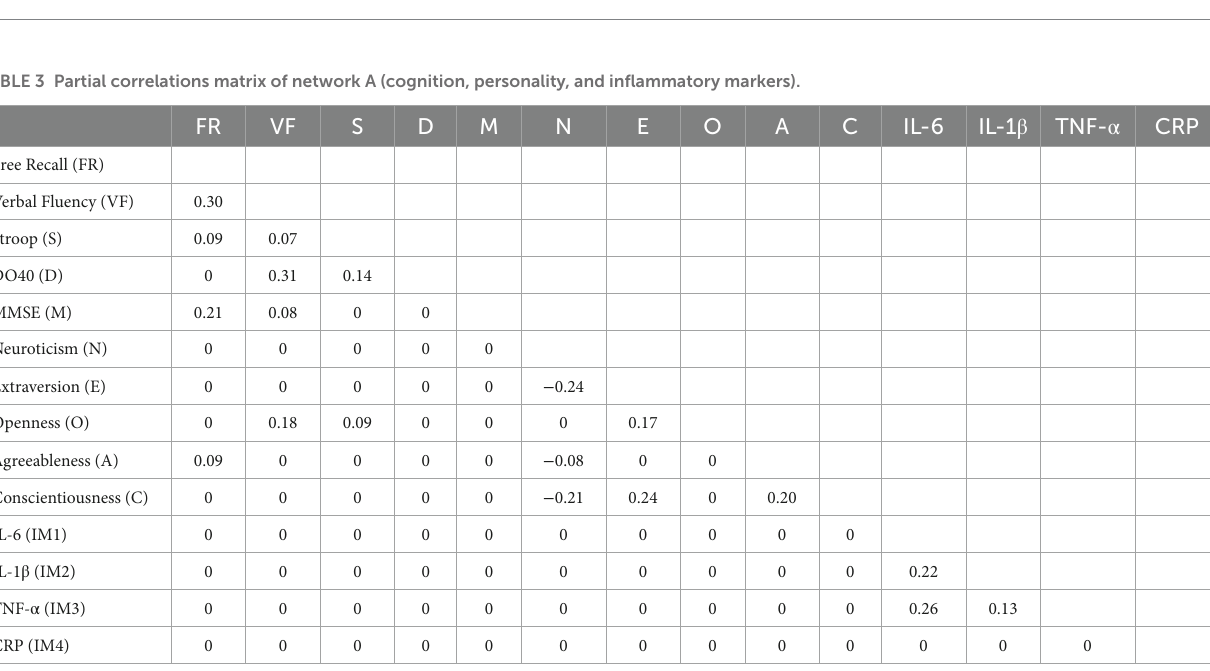
FIGURE 2 Network displaying the relationships between cognition, personality, and inflammatory markers before (A) and after (B) controlling for covariates. Green edges indicate positive partial correlations, while red edges indicate negative partial correlations. The thickness of the line indicates the strength of the relationship.